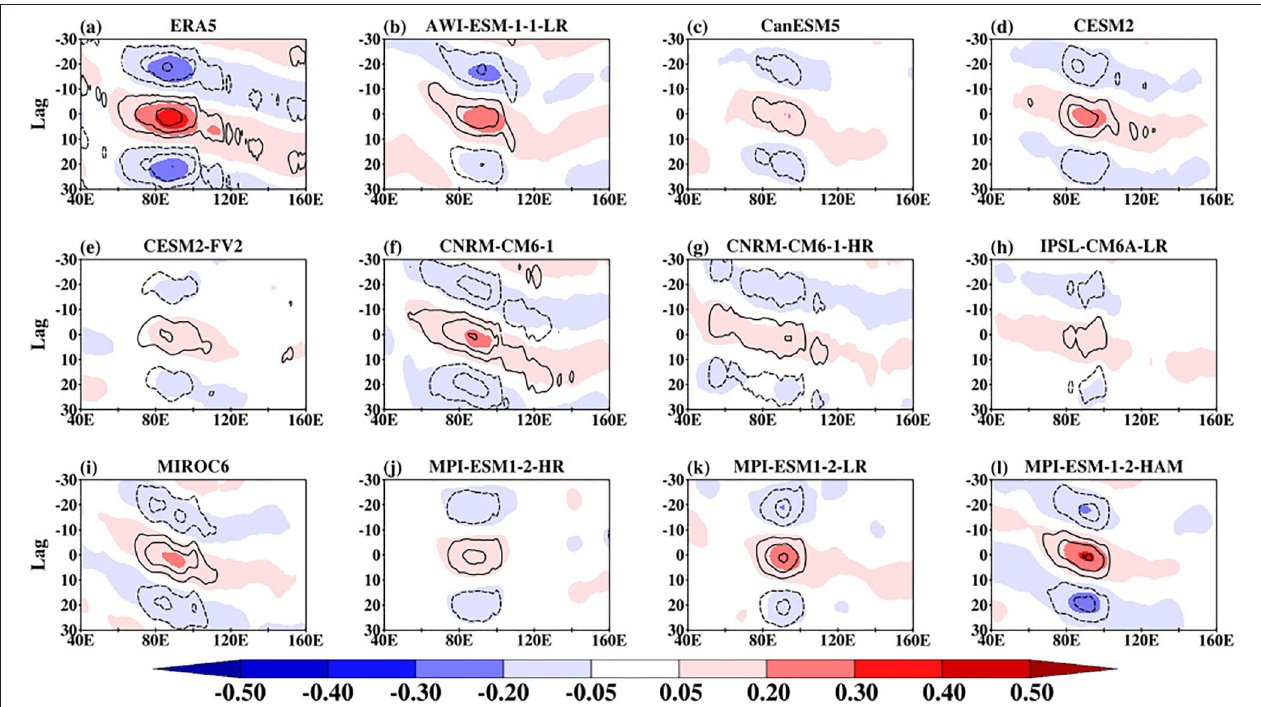
FIGURE 12 | Eastward propagation of observed (a) and simulation (b–l) BSISO convection signal indicated by column integrated MSE (shaded) and 30-60-day rainfall anomalies (contours; starting from ± 0.2 to ± (a) 0.6 at an interval of 0.2) averaged over 10 ◦ S − 10 ◦ N by lag-correlation against 30–60-day rainfall anomalies averaged over the equatorial Indian Ocean (5 ◦ S and 5 ◦ N, 80 ◦ E and 100 ◦ E). but with some notable biases (rmse ranges from 0.70 to